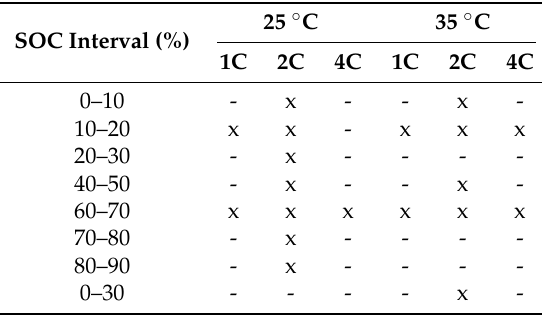
Table 1. Cycling test matrix for developing and verifying the empirical model for various State of Charge (SOC) intervals, temperatures, and